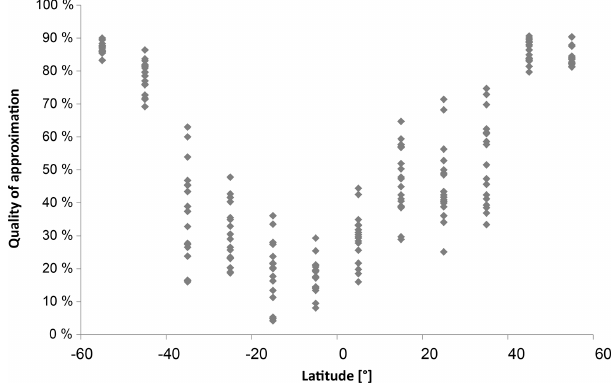
Figure 6. Quality of approximation as shown in Table 1 versus lati- tude. All longitudes are plotted but not separated by colour in order to keep the figure clear.